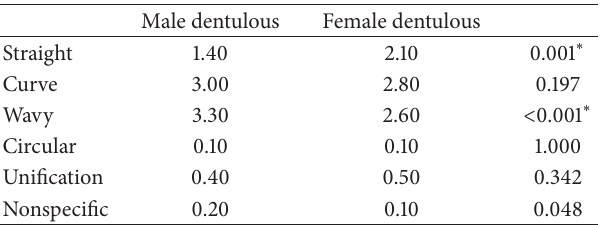
Table 2: Table showing the mean value of different rugae patterns among dentulous subjects.